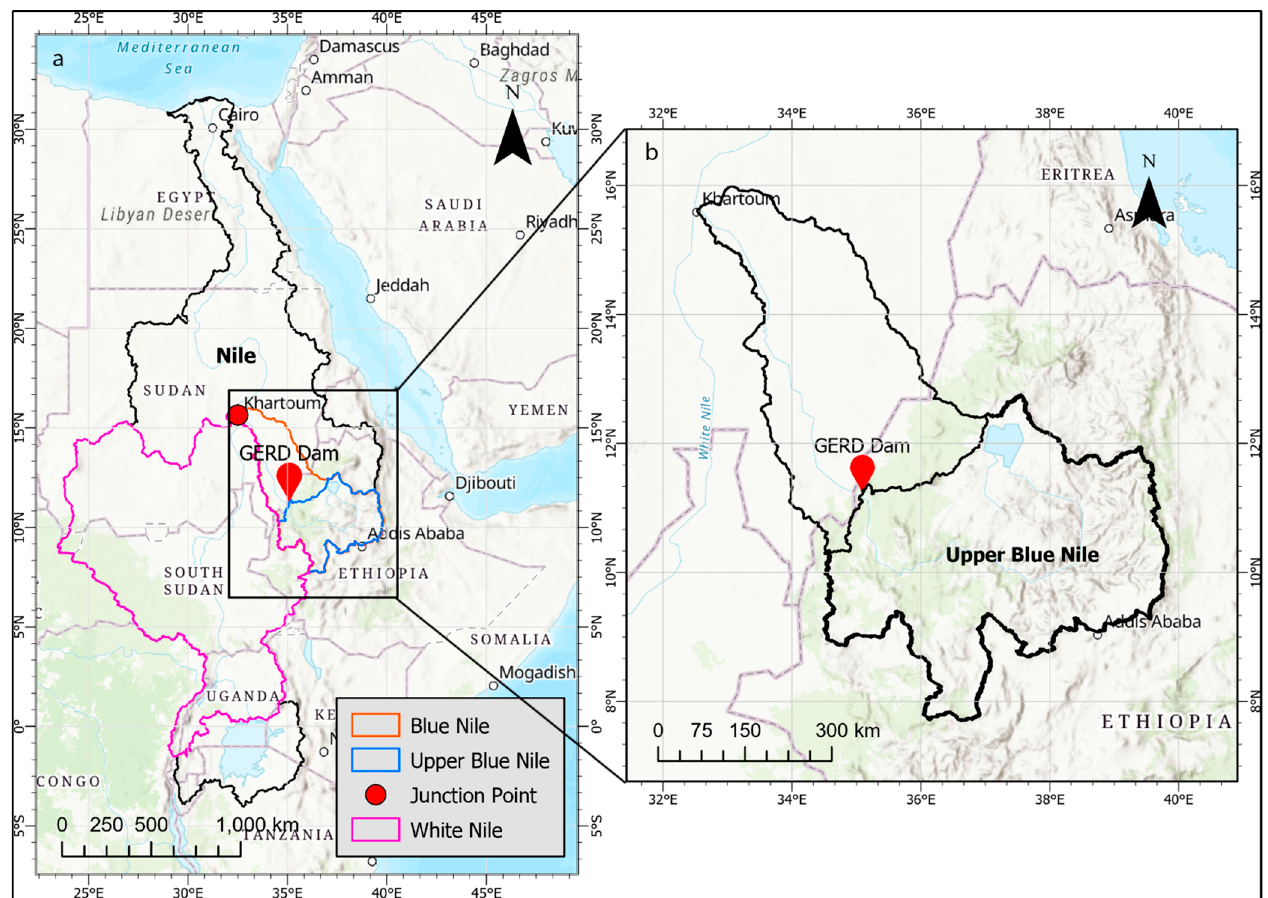
Figure 1. Subfigure ( a ) shows the Nile River Basin and its subbasins—White Nile River Basin and Blue Nile River Basin. The White Nile River and the Blue Nile River merge at Khartoum, Sudan, which is shown as the junction point in the figure. Inset Figure ( b ) shows the Blue Nile River Basin along with the location of the Grand Ethiopian Renaissance Dam (GERD) near the Ethiopian–Sudanese border.